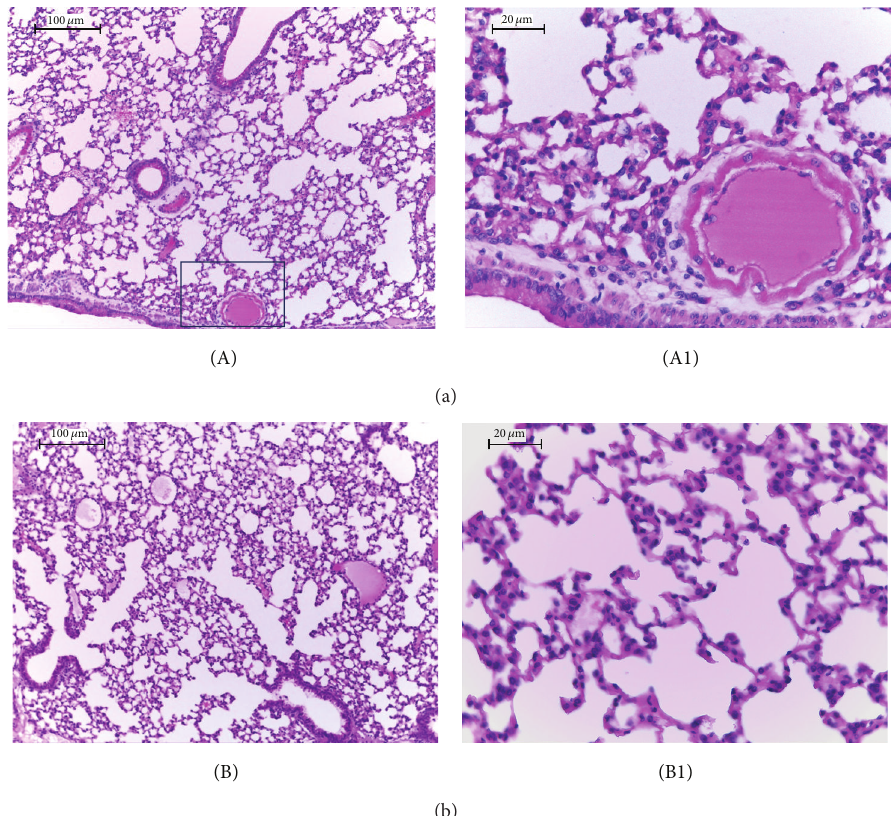
Figure 2: Effect of DEC treatment on histological alterations in lung after carrageenan-induced injury; (A)-(A1) lung sections taken from mice with carrageenan-induced pleurisy demonstrated tissue injury as evidenced in edema, cellularity enhancement, and polymorphonuclear infiltration. (B)-(B1) Treatment with DEC three days prior to pleurisy demonstrated reduced lung injury and PMN infiltration. The figure is representative of at least 3 experiments performed on different experimental days. 𝑛 = 10 mice for each group; scale bar = 100 𝜇 m and 20 𝜇